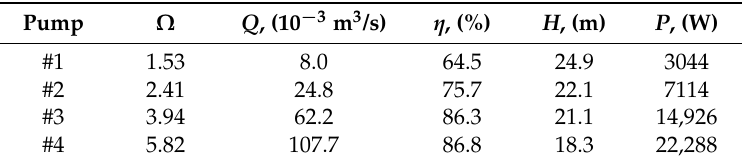
Table 1. Pump characteristics at Best Efficiency Point (BEP) [11].